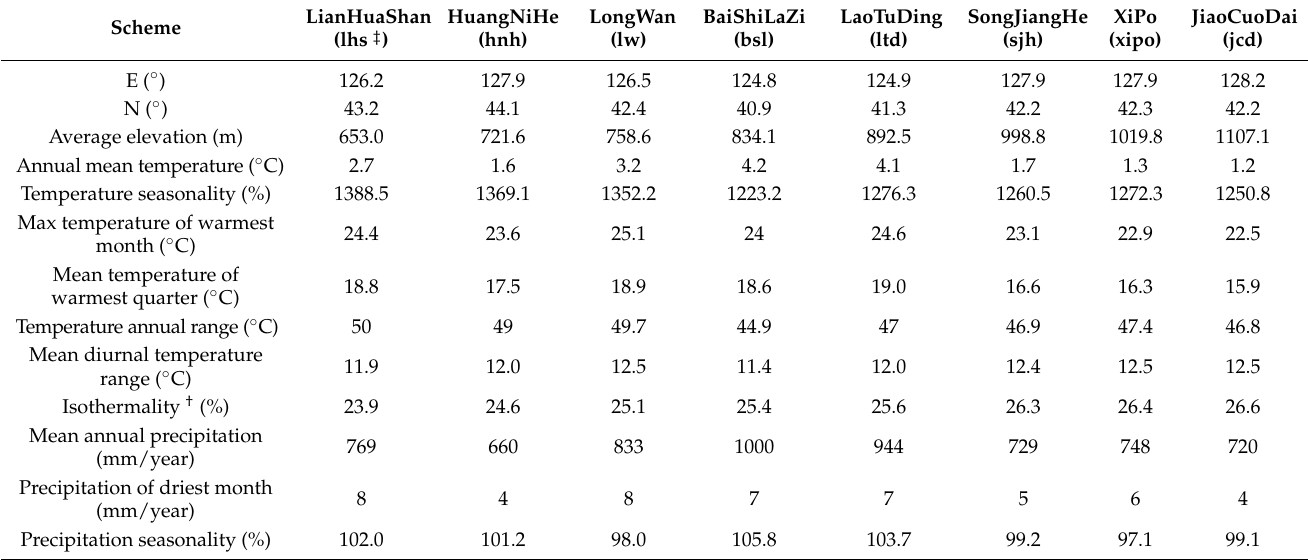
Table 1. The descriptive summary of the studied